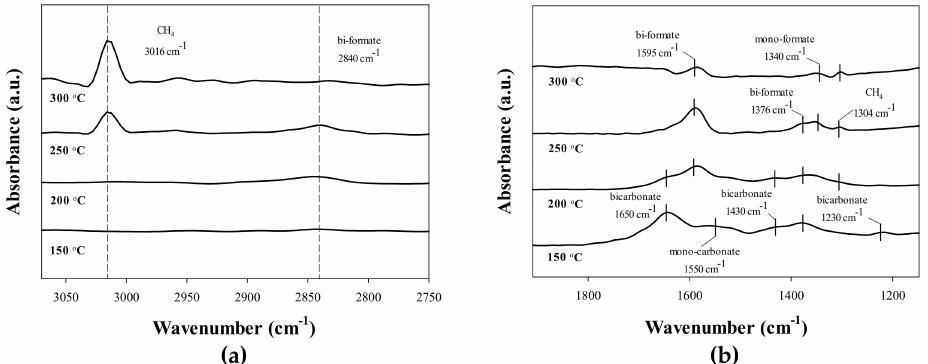
Figure 8. In-situ DRIFT spectra of CO 2 methanation on Ni / Al@MnAl 2 O 4 (DP) from 150 to 300 ◦ C in wavenumber range 2750–3070 cm − 1 ( a ) and in wavenumber range 1150–1910 cm − 1 ( b ). Total flow of 50 mL / min: 1 mol.% CO 2 , 50 mol.% H 2 , 49 mol.%